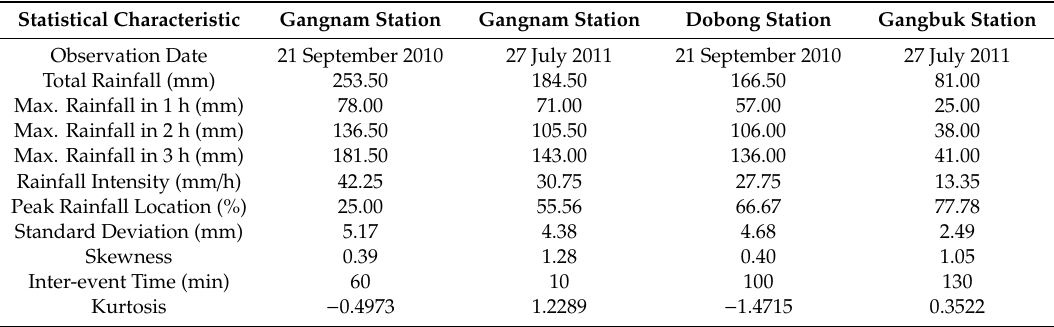
Table 2. Observed rainfall and statistical features (four observation stations in the Seoul area).